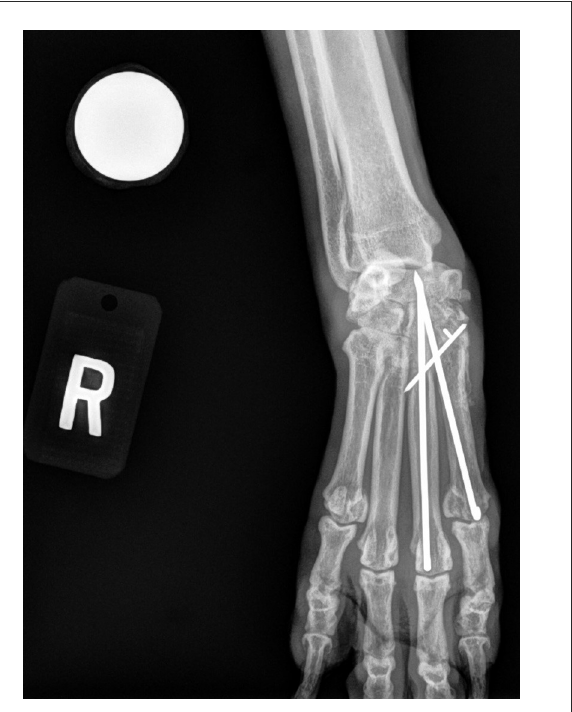
FIGURE3 Post-operative partial carpal arthrodesis anterior to posterior view of the right carpus showing implant interference of the pin and antebrachiocarpal